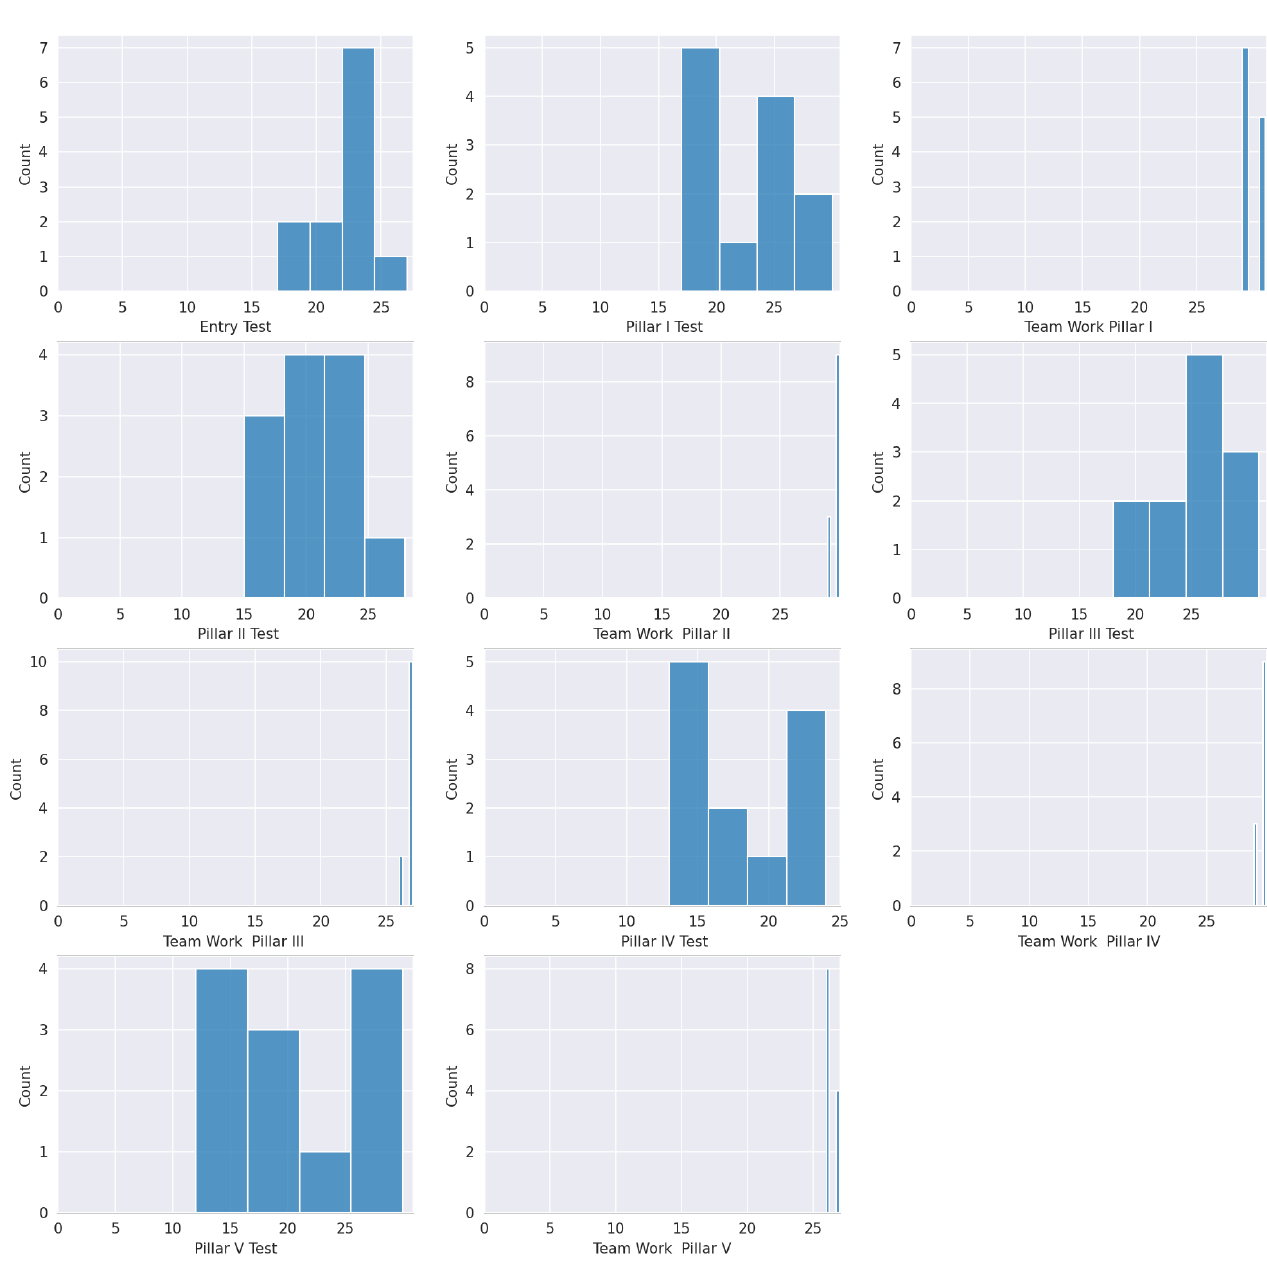
Figure 2. The distribution of the students’ marks for the academic year